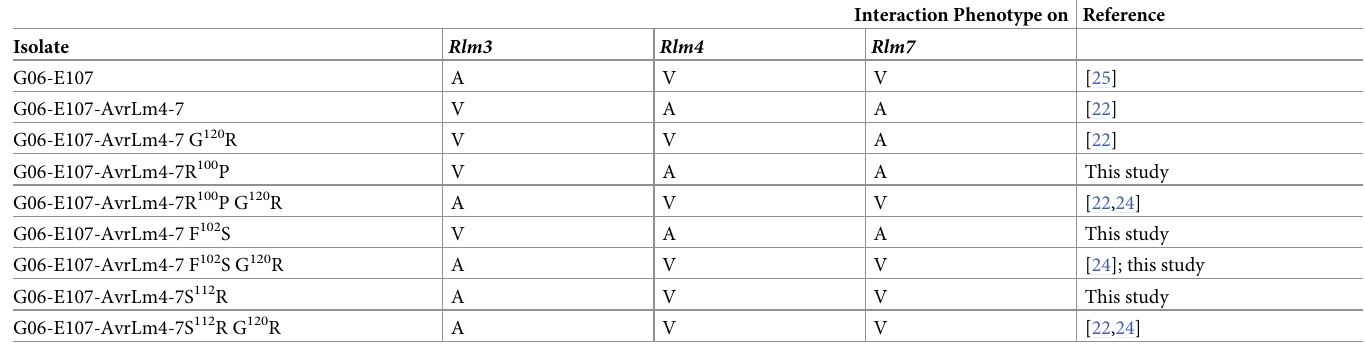
Table 2. Interaction phenotypes on Brassica napus resistant genotypes of Leptosphaeria maculans wild-type or transformed isolates with different site-directed mutagenized alleles of AvrLm4-7 .